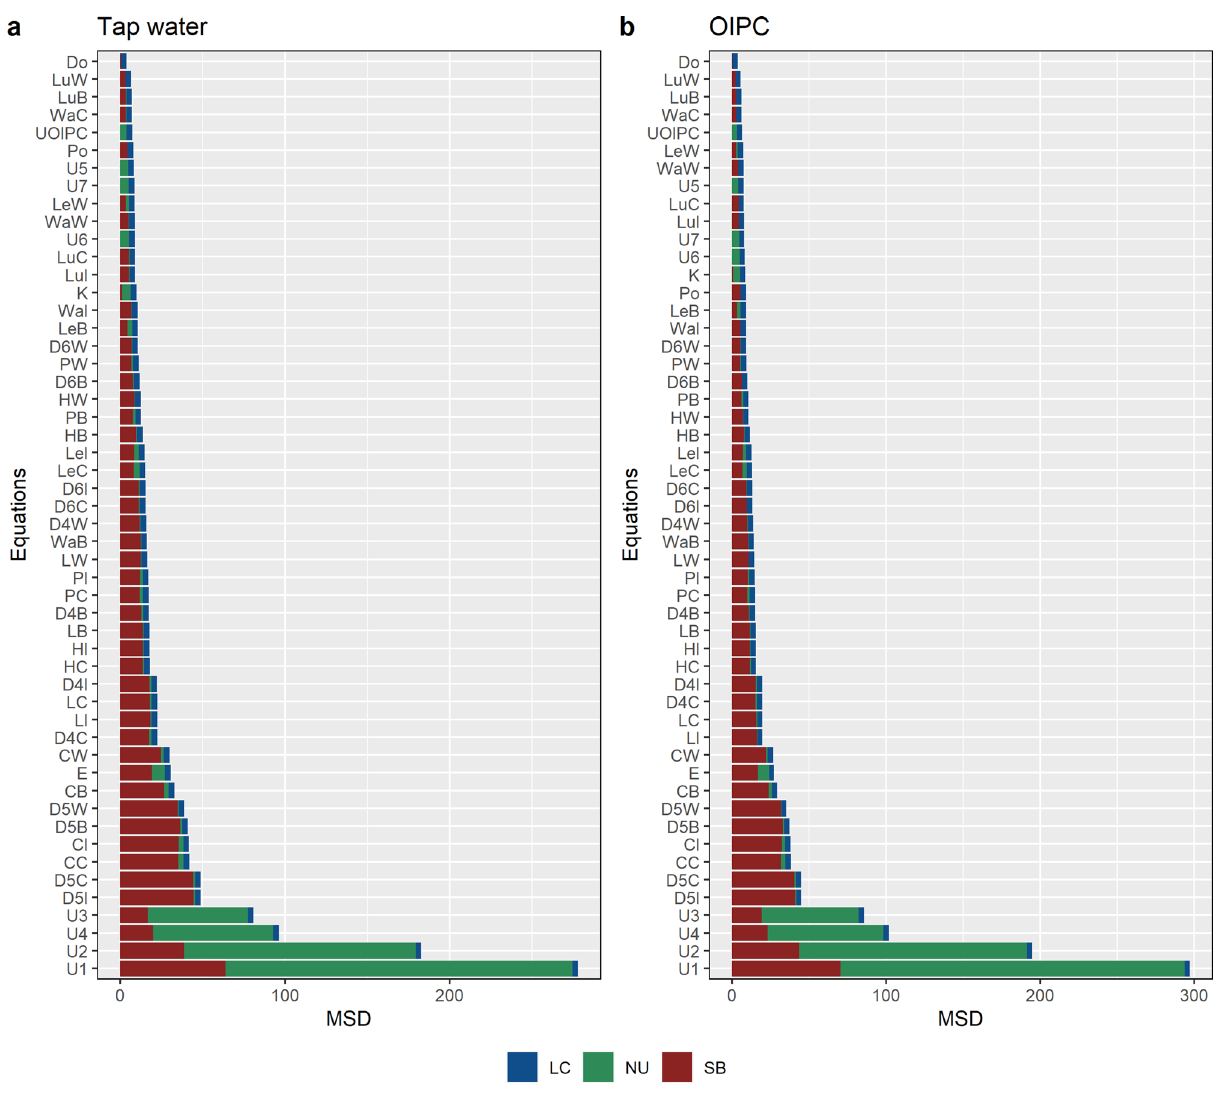
Figure 13. A direct comparison of the mean standard deviation (MSD) between predicted and observed δ 18 O dw values for ( a ) tap water and ( b ) OIPC. δ 18 O dw values were predicted from δ 18 O c values of all samples (n = 75) from the current study with existing predictive models or a combination of models. MSD components are lack of correlation (LC), non-unity slope (NU) and squared bias (SB). Low MSD indicates greater similarity between modelled and measured